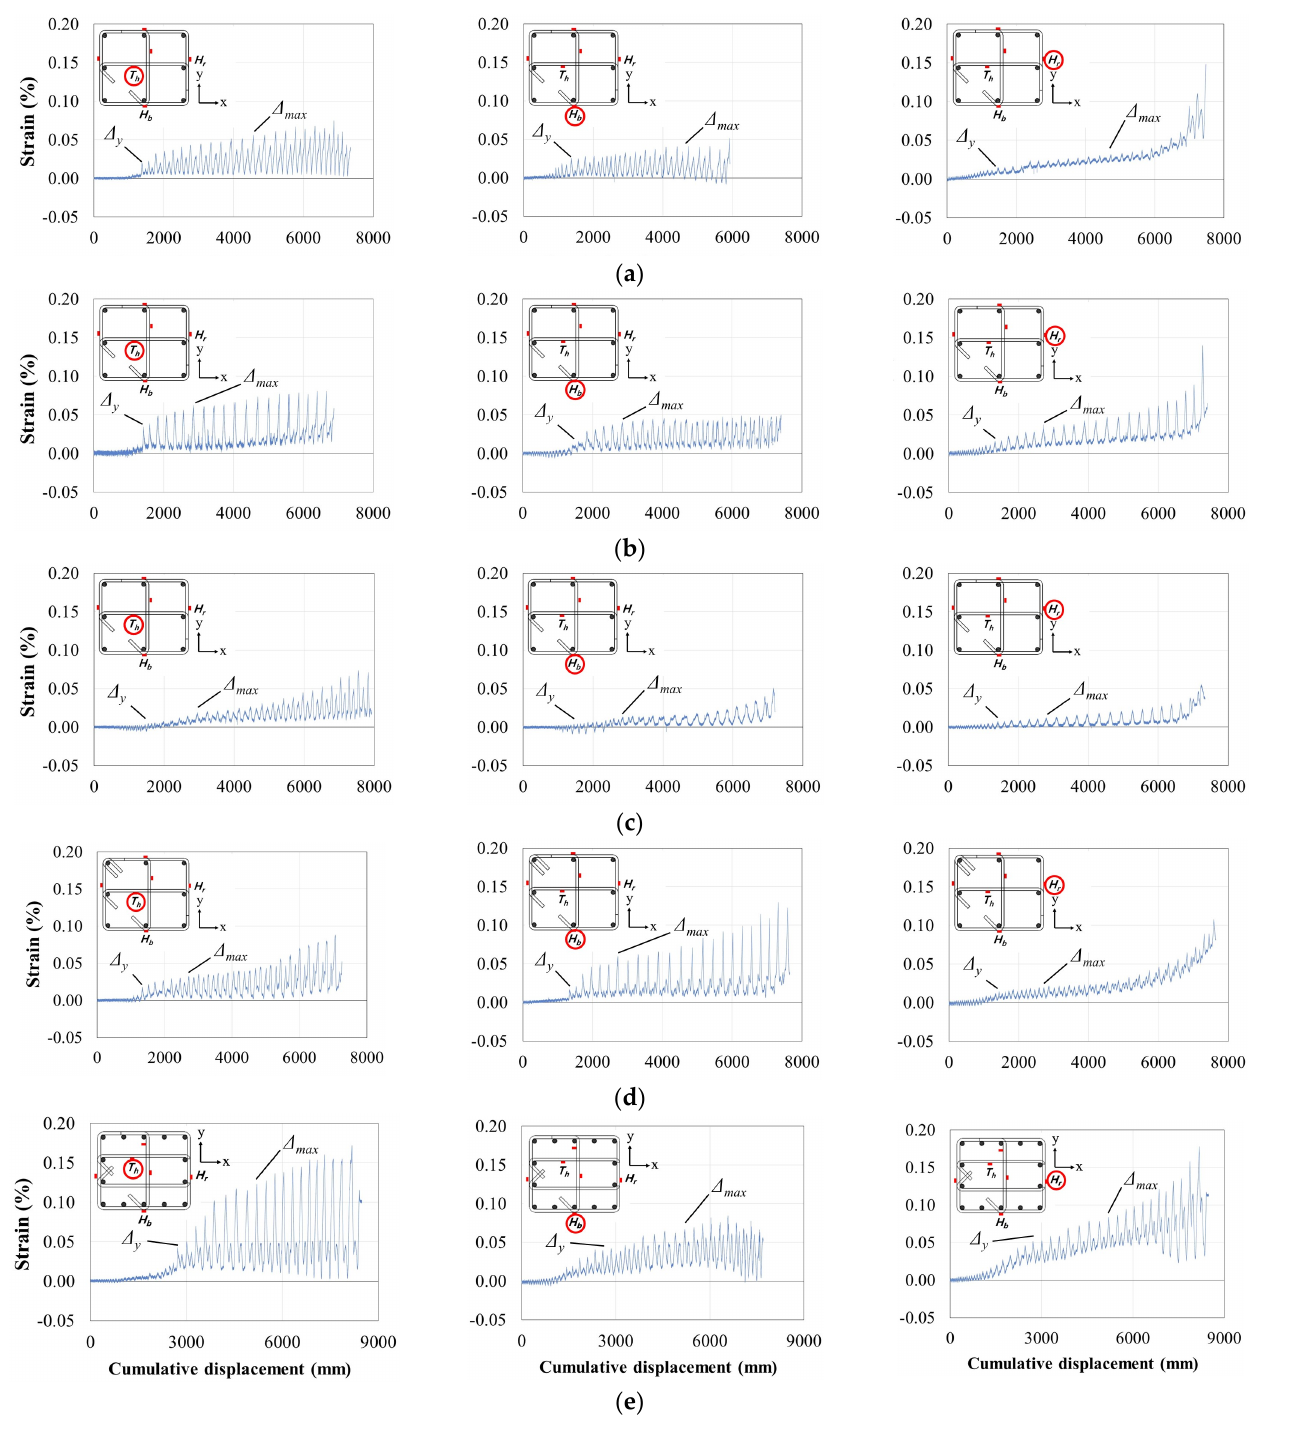
Figure 8. Strain distributions of transverse reinforcement (in the order of T h , H b , and H r ): ( a ) C1; ( b ) C2; ( c ) C3; ( d ) C4; ( e )